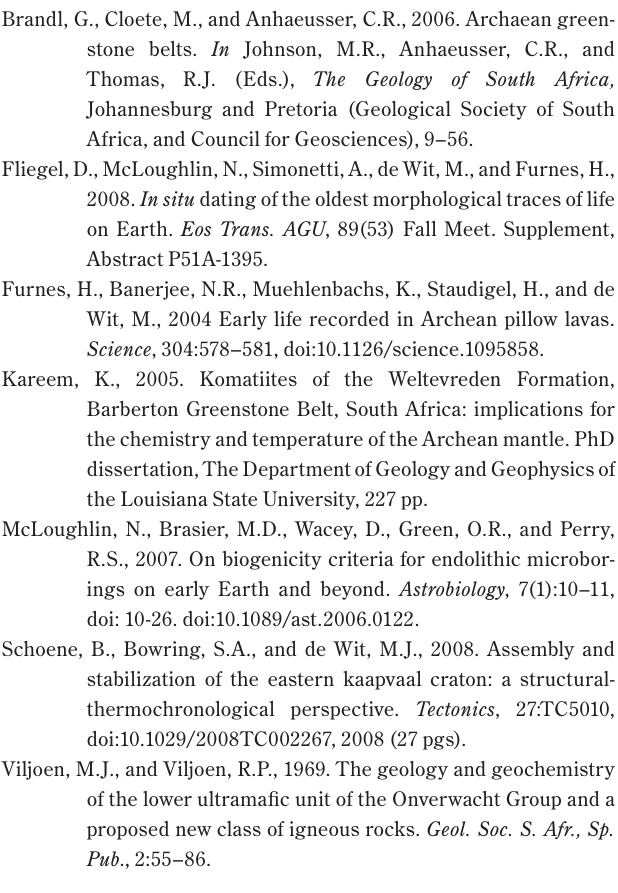
Fig. 1, 3: Eugene G. Grosch (AEON, Cape Town) Fig. 2: Photo by Harald Furnes (CGB, Bergen) Fig. 4: Photo by Eugene G. Grosch (AEON, Cape Town) Fig. 5. Photomicrograph by Nicola McLoughlin (CGB,